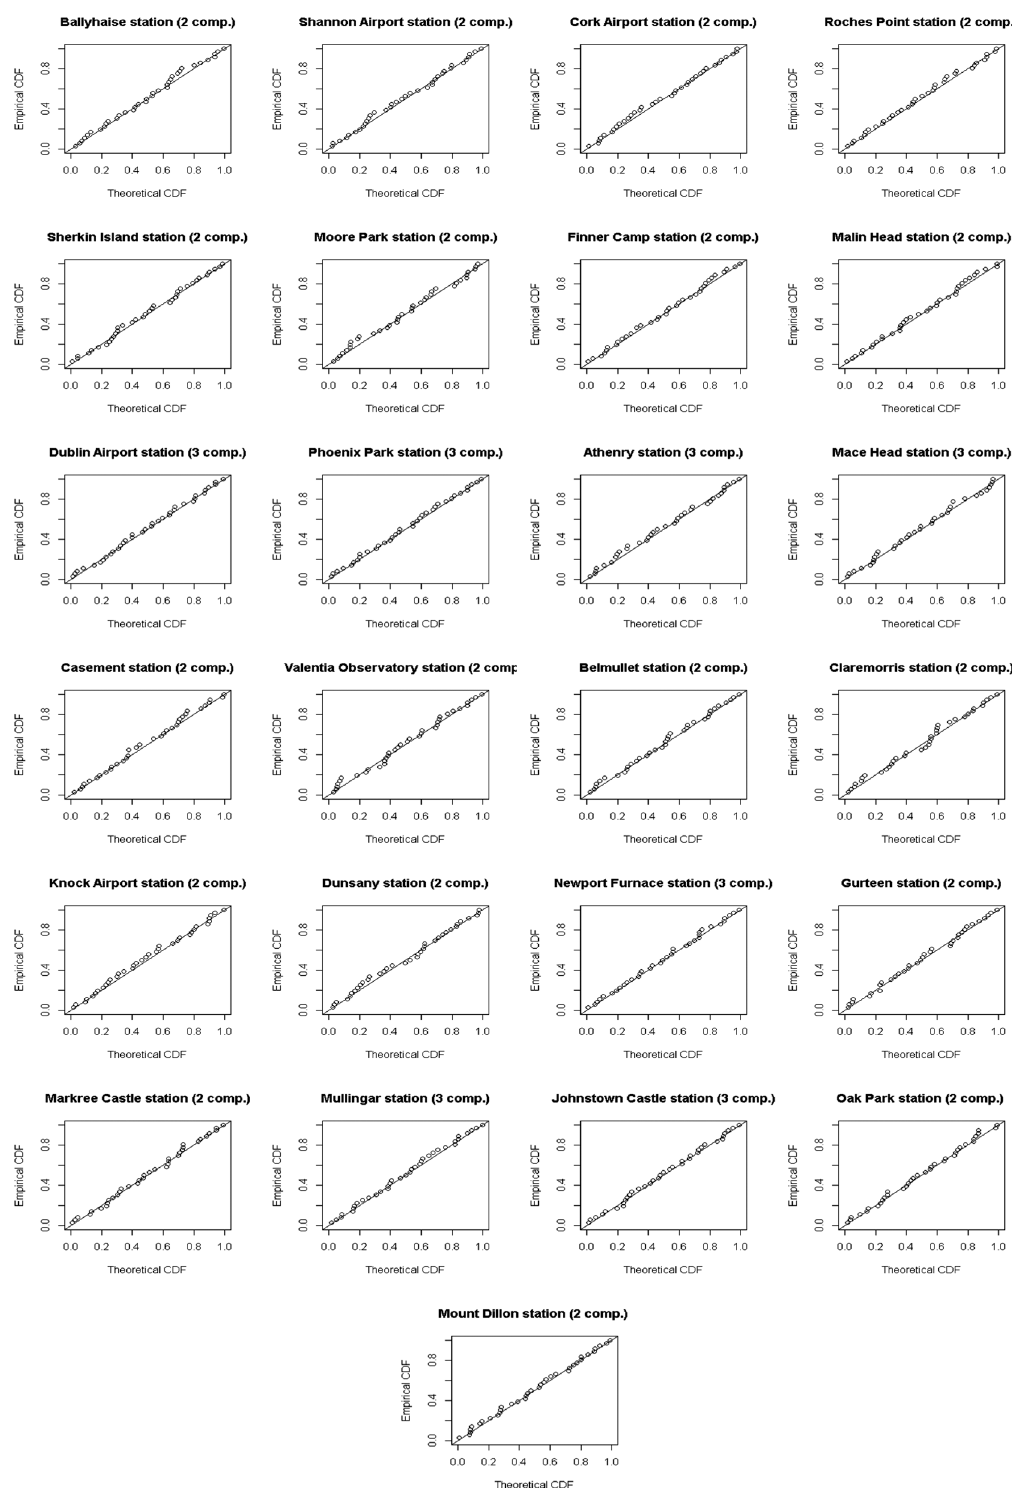
Figure 2: The CDF plots for the model selected by the proposed model selection criteria for each